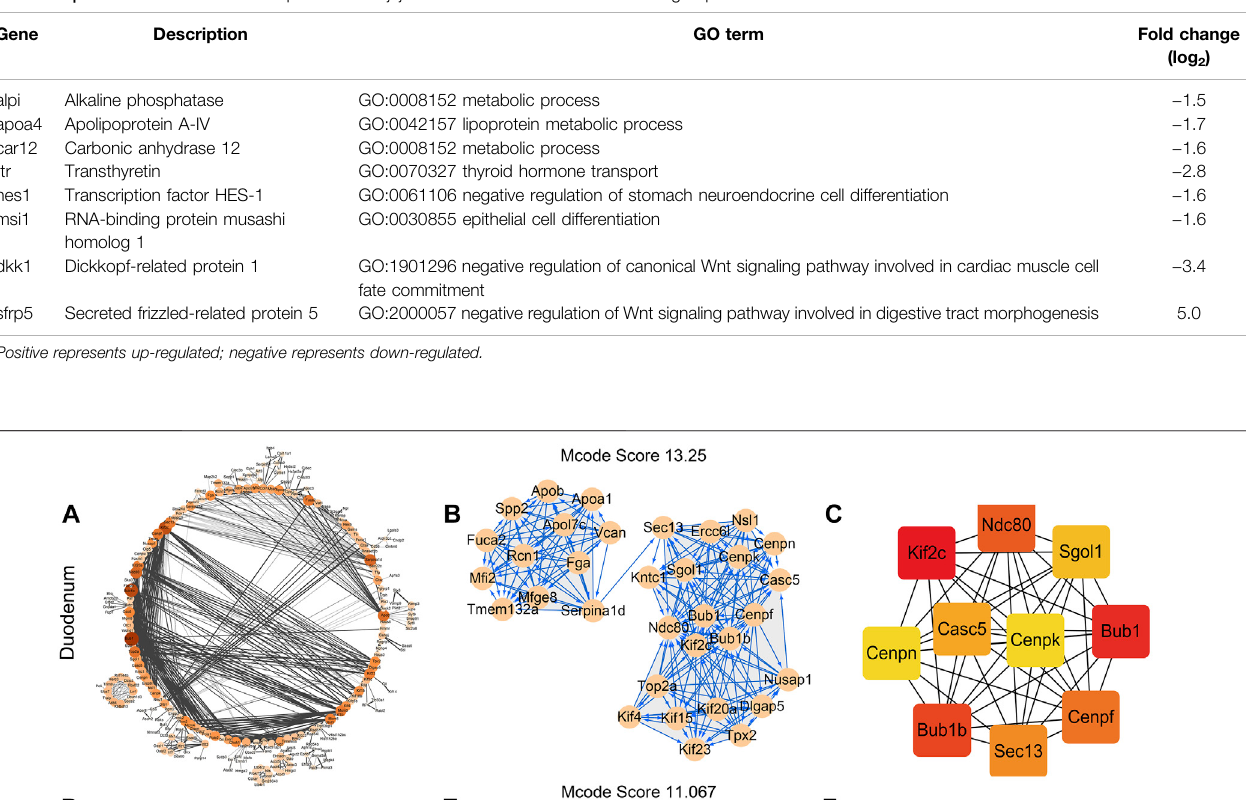
TABLE 3 | Markers of intestinal development in the jejunum between the IUTN and IUHS